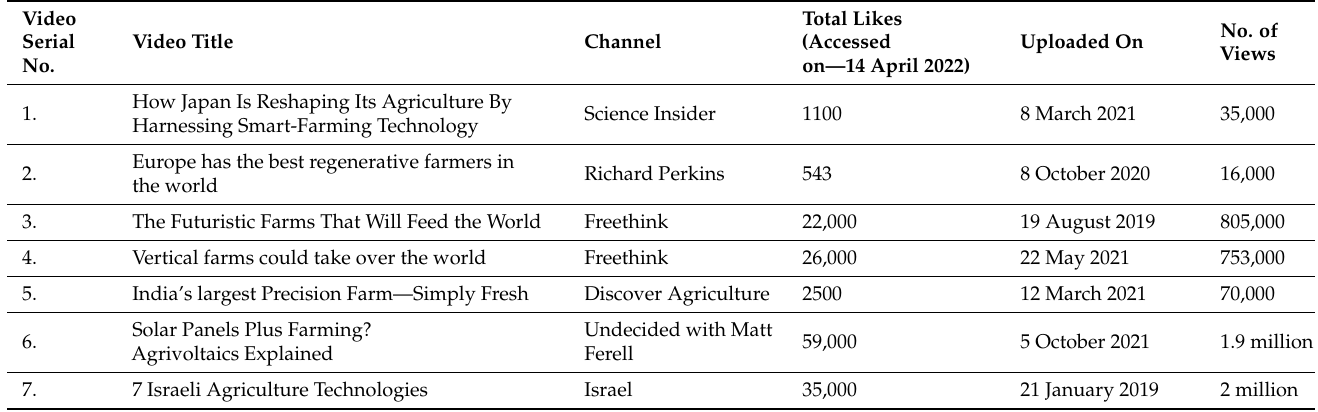
Table 7. Videos selected for sentiment